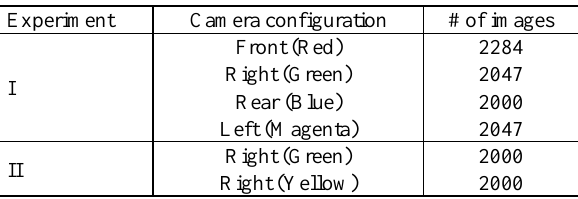
Table 1 . The data size of each experiment.